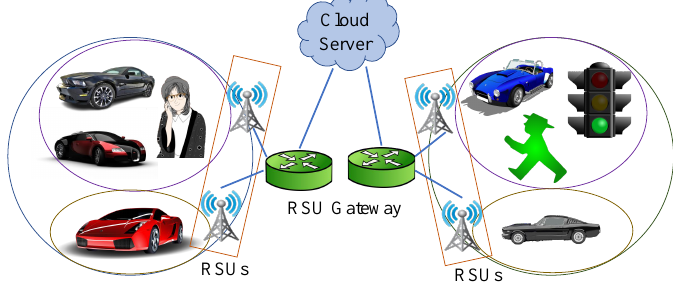
Figure 3. IoV system